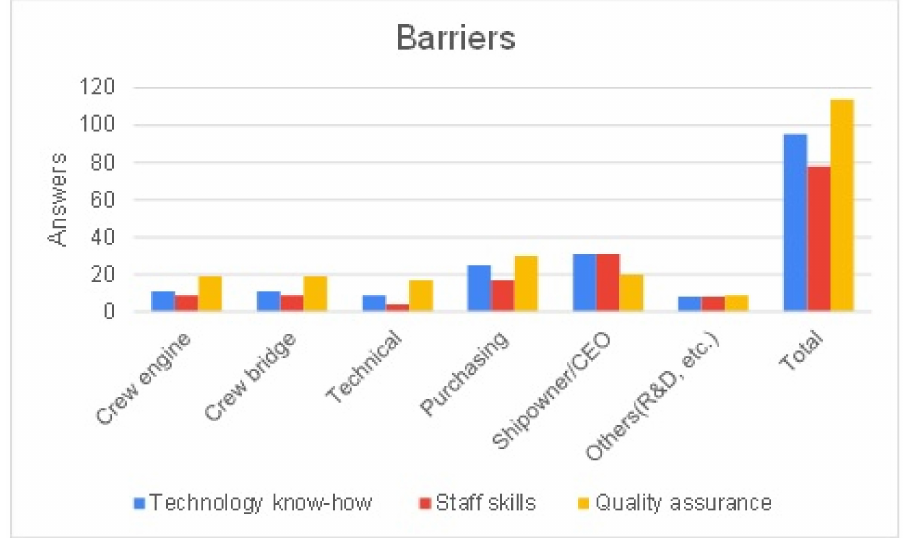
Figure 6. Barriers of using parts made by 3D